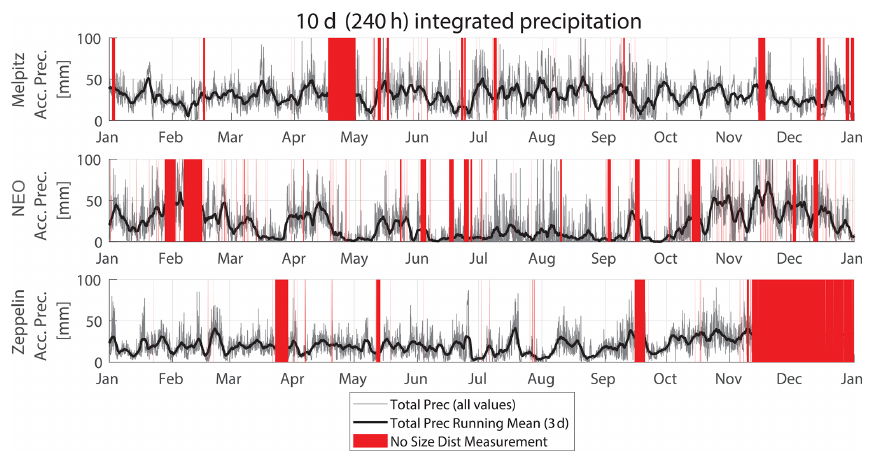
Figure 6. Total accumulated precipitation (Acc. Prec.) for each 10d trajectory for the three stations (grey line). The black line is a moving 3d mean, and red areas are periods with no input data (no size distribution (Dist) measurement and hence no simulations). The y axis is set to 0–100mm even though there are a few peaks with higher values.